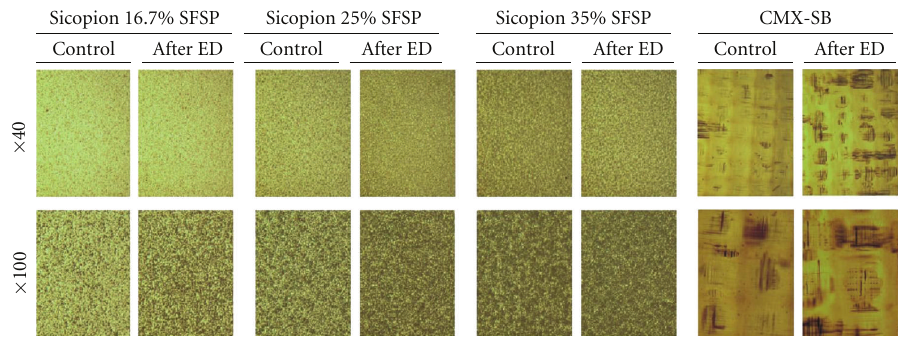
Figure 6: Optical microscope images of unused (control) and used (after ED) CEM at × 40 and × 100 magnifications.